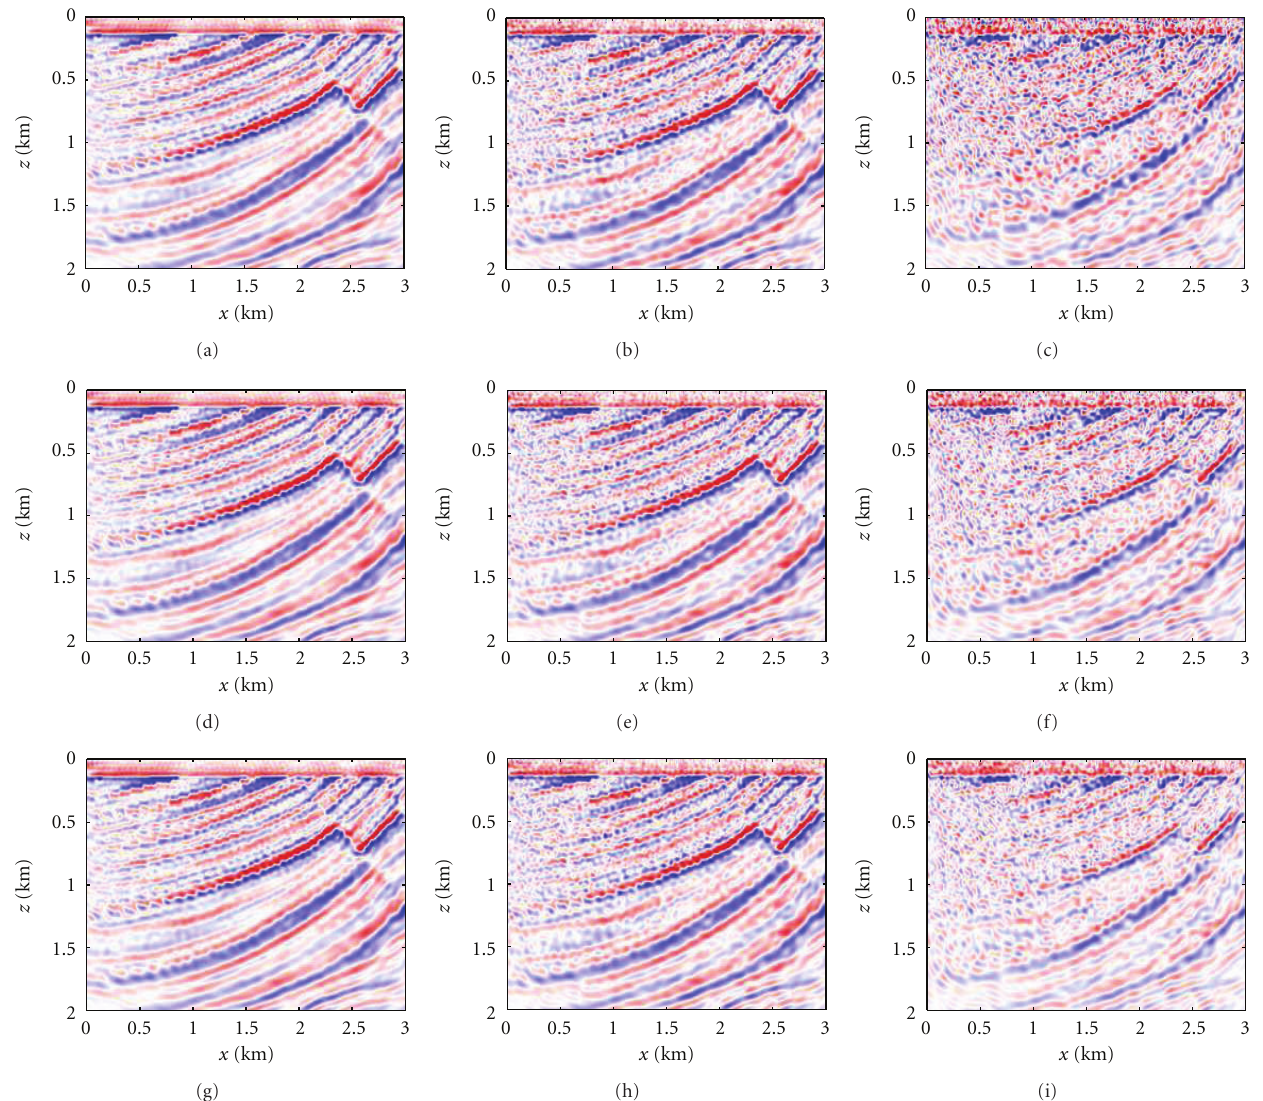
Figure 9: Inversion result for the SA approach without averaging for various batch sizes and noise levels. The rows represent di ff erent batch sizes K = 1, 5, 10, while the columns represent di ff erent noise levels: no noise, SNR = 20 dB, and SNR = 10dB. We obtain good results with K = 1, and the quality does not improve dramatically for larger batch sizes, except for the highest noise